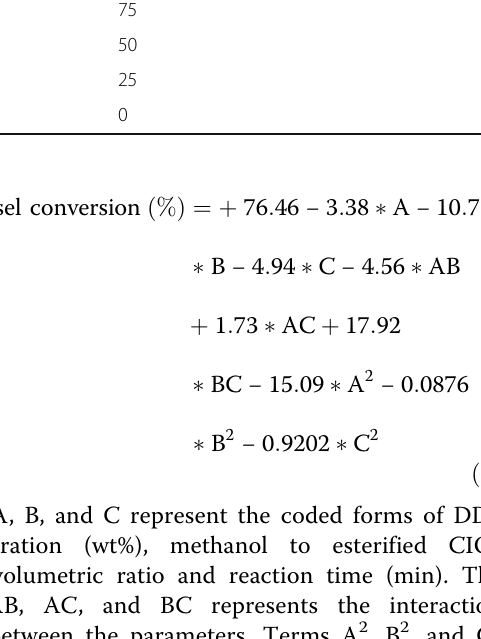
Table 3 Different blends of CIO and WCO and its corresponding acid values S. No Calophyllum inophyllum oil (%)